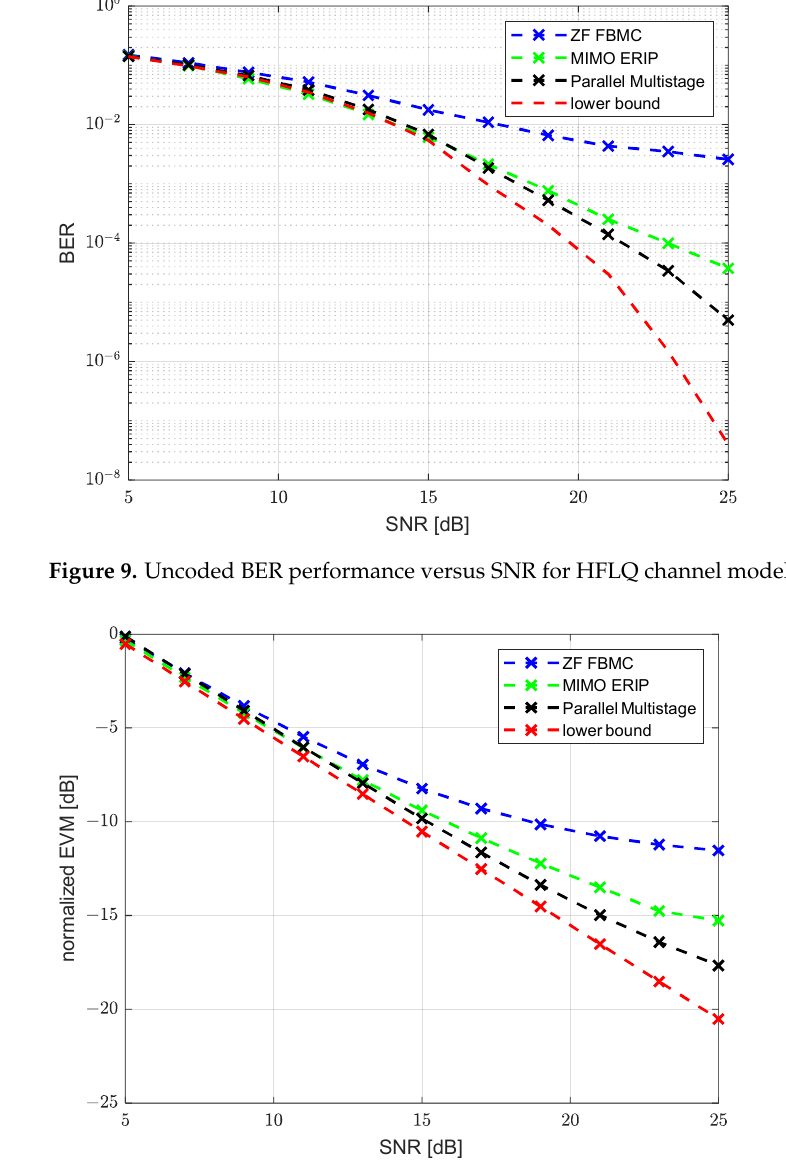
13 of 16 Figure 8. EVM performance versus SNR for HFHQ channel model. Figures 9 and 10 show the dependence of the uncoded BER and EVM over the SNR